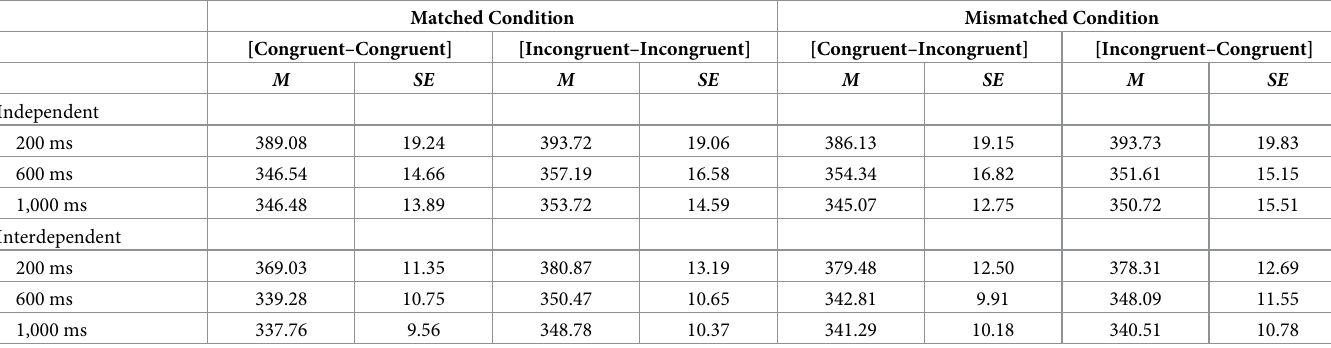
Table 6. Raw reaction times for East Asian Canadians.